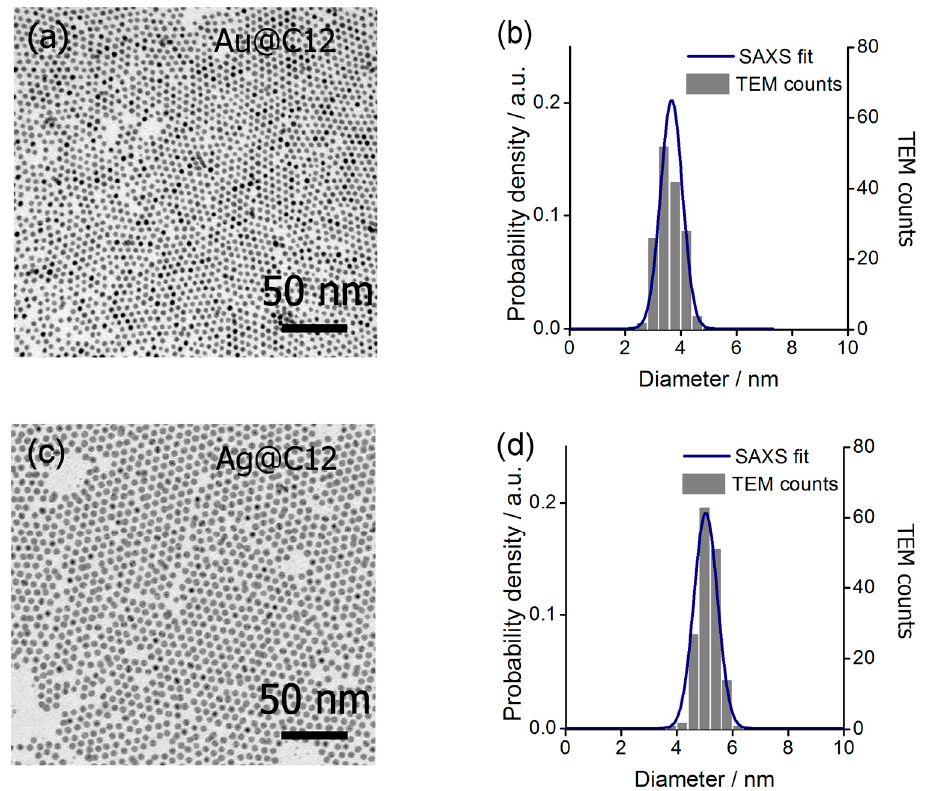
Figure 2. Structural investigation of Au@C12 and Ag@C12 nanoparticles. ( a ) TEM micrograph of Au@C12 monolayer ( b ) Distribution of Au@C12 nanocrystal diameter based on SAXS experiment and TEM analysis. ( c ) TEM micrograph of Ag@C12 monolayer. ( d ) Distribution of Ag@C12 nanocrystal diameter based on SAXS experiment and TEM analysis.